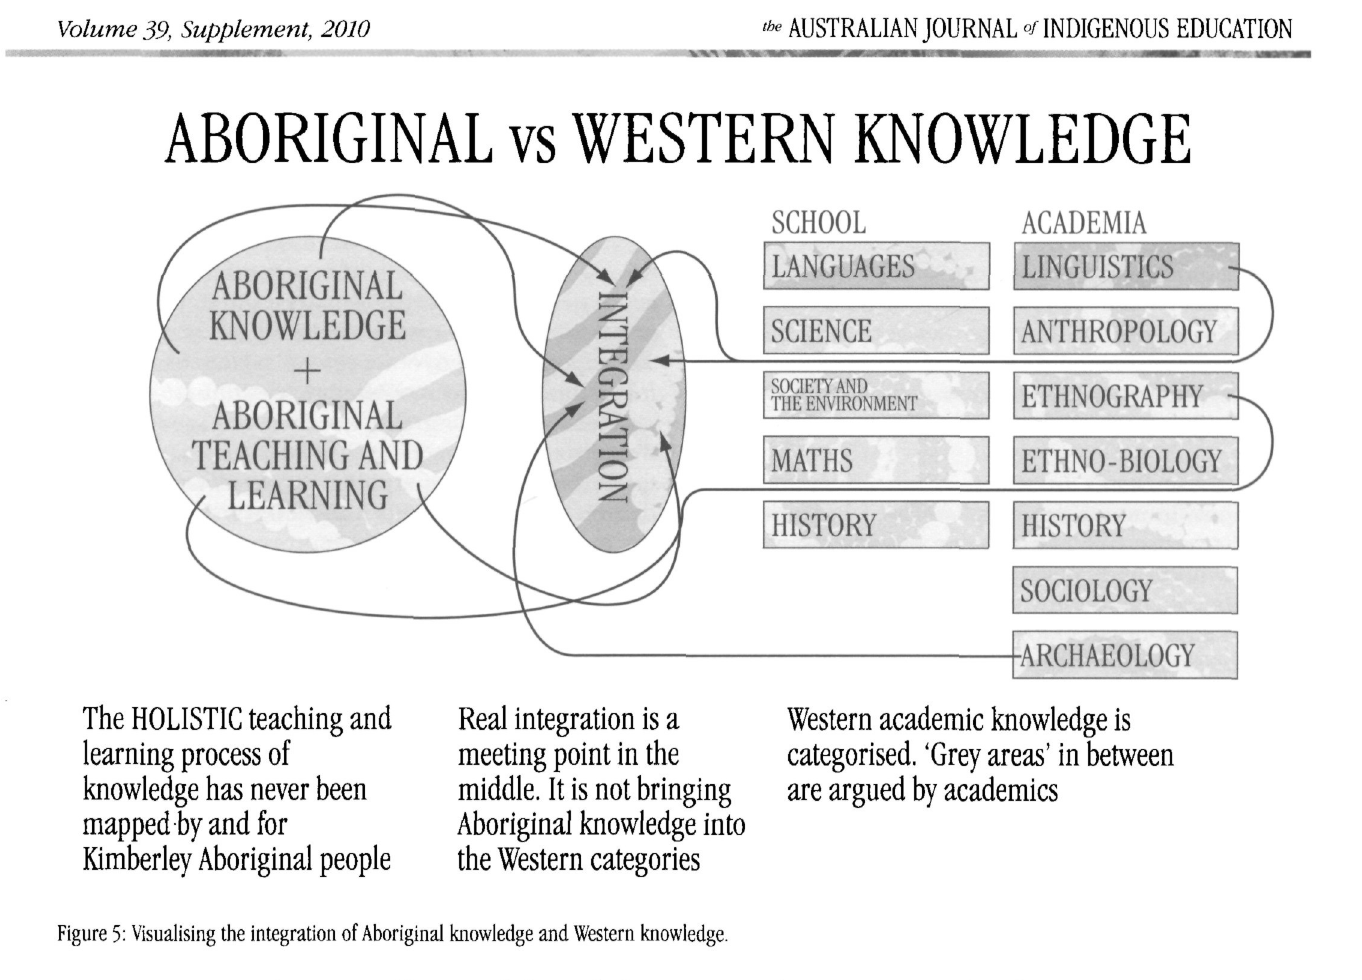
Figure 5: Visualising the integration of Aboriginal knowledge and Western knowledge. constant tension between Aboriginal knowledge systems and non-Aboriginal ones places barriers at just about every step of Figure 4 and prevents the organisation from being able to direct resourcing to the left hand end of the Language Continuation Continuum (Figure